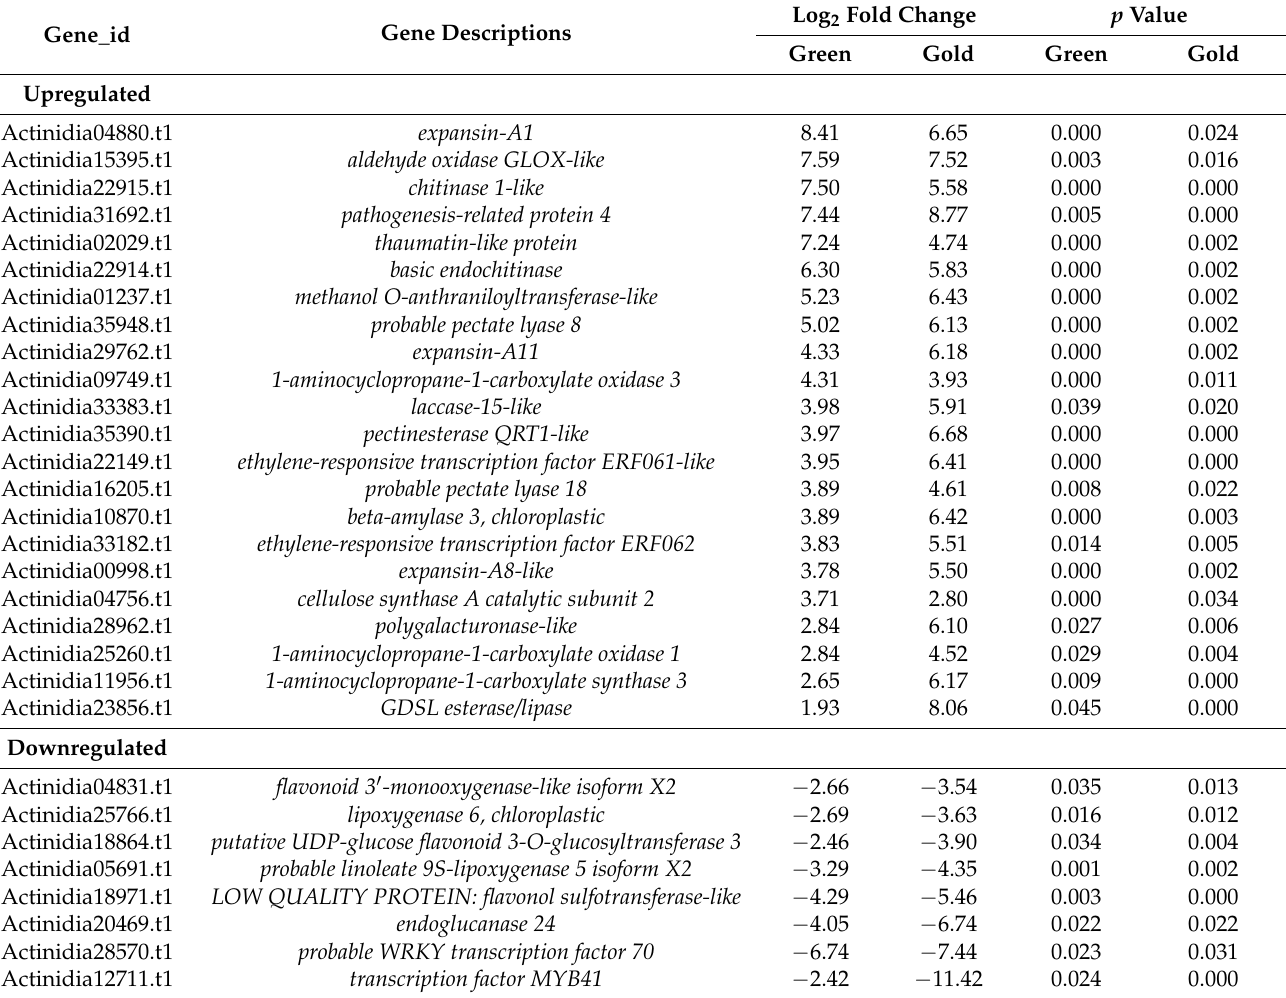
Table 2. List of DEGs common to green ‘Hayward’ and gold ‘Haegeum’ kiwifruit in the comparison of ethylene treated vs. control.